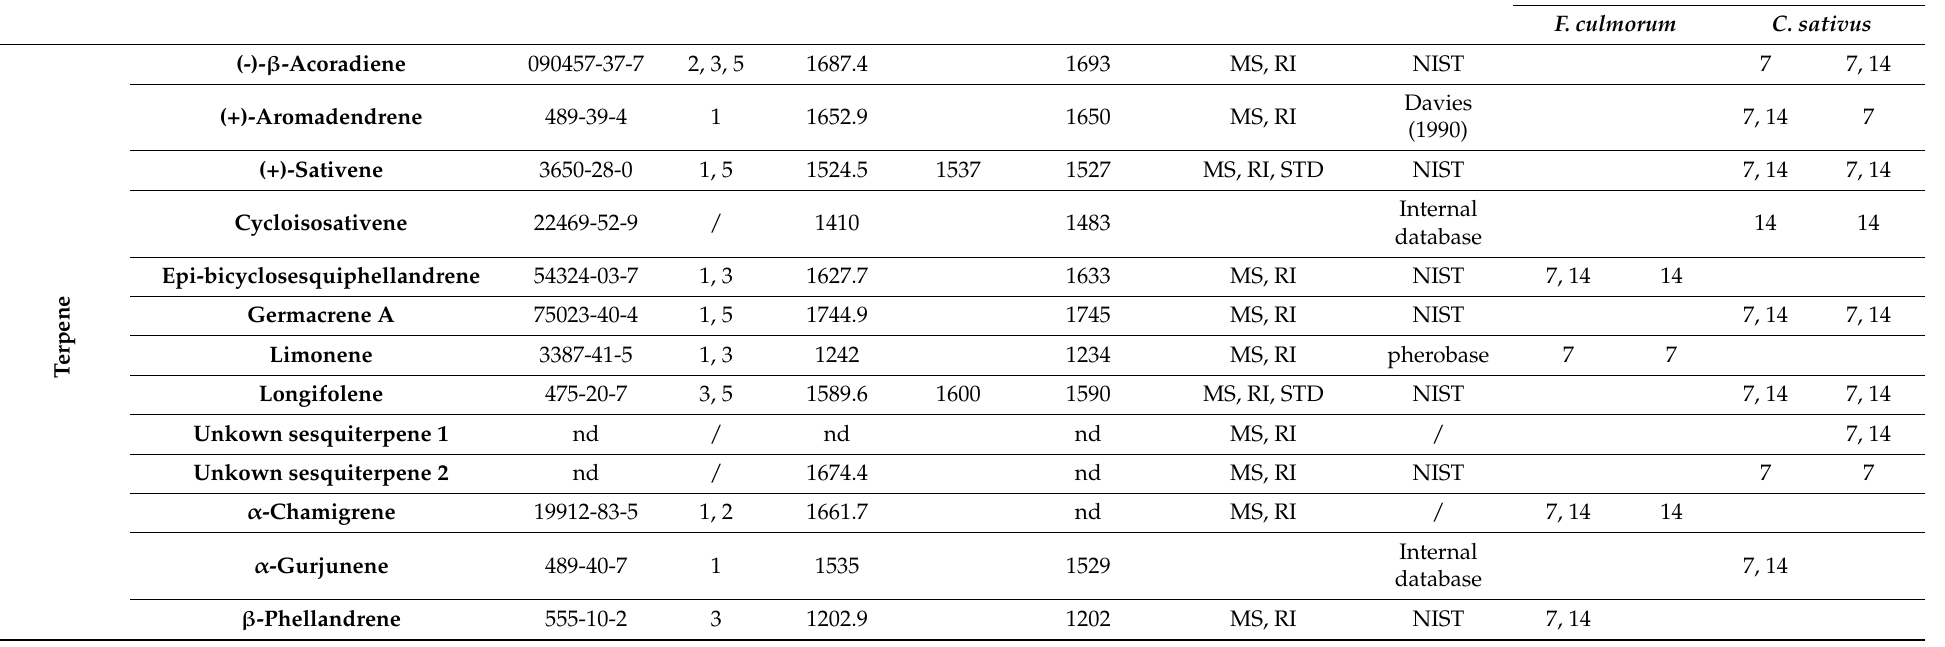
Emitted by F. culmorum C.